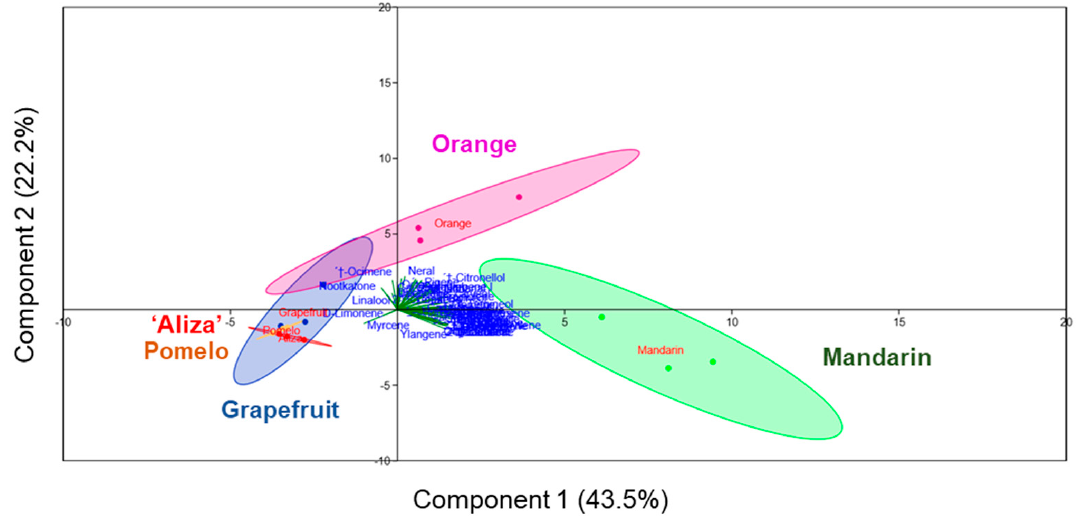
Figure 8. Biplot PCA chart of the aroma volatile contents of ‘Aliza’, grapefruit, pomelo, orange and mandarin. The marked ellipses indicate the 95% probability that a new observation from the same group will fall inside the ellipse.